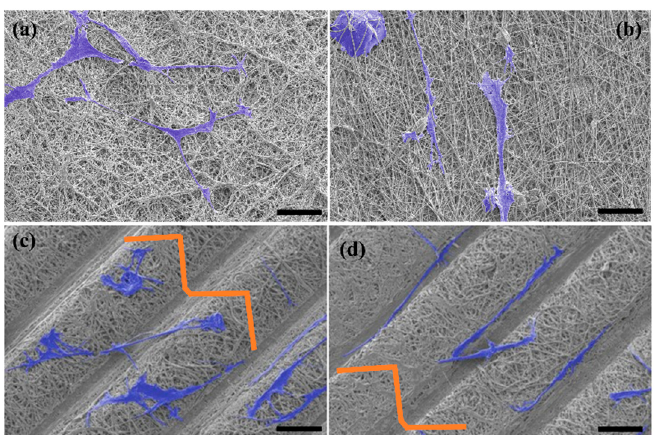
Figure 8. Morphologies of HDF cells on day 8 of incubation on different morphologies of ( a , b ) 2D scaffold and ( c , d ) structural scaffold. Scale bar represents 50 µm.